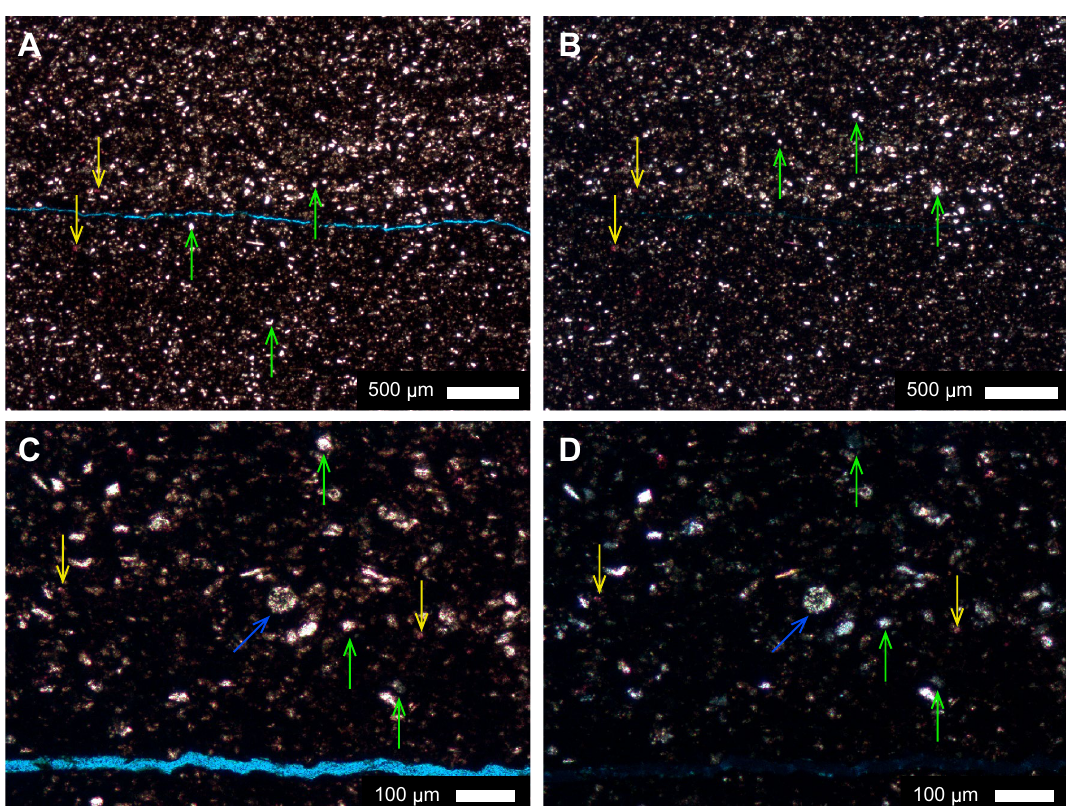
Figure 3. Thin section photos from the Kaybob well (04-19-064-22W4). All sections were polished, impregnated with blue epoxy to highlight porosity, and half stained with Alizarin red to detect calcite and aragonite content. ( A ) Depth 3309 m (upper Duvernay), plane polarized light, SiO 2 (yellow arrows, down), and CaCO 3 (green arrows, pointing up). ( B ) Same as A in crossed polarized light. ( C ) Depth 3309 m (upper Duvernay), plane polarized light, SiO2 (yellow arrows, down), CaCO3 (green arrows, up), possible radiolarian (blue arrow, diagonal). ( D ) Same as ( C ) in crossed polarized